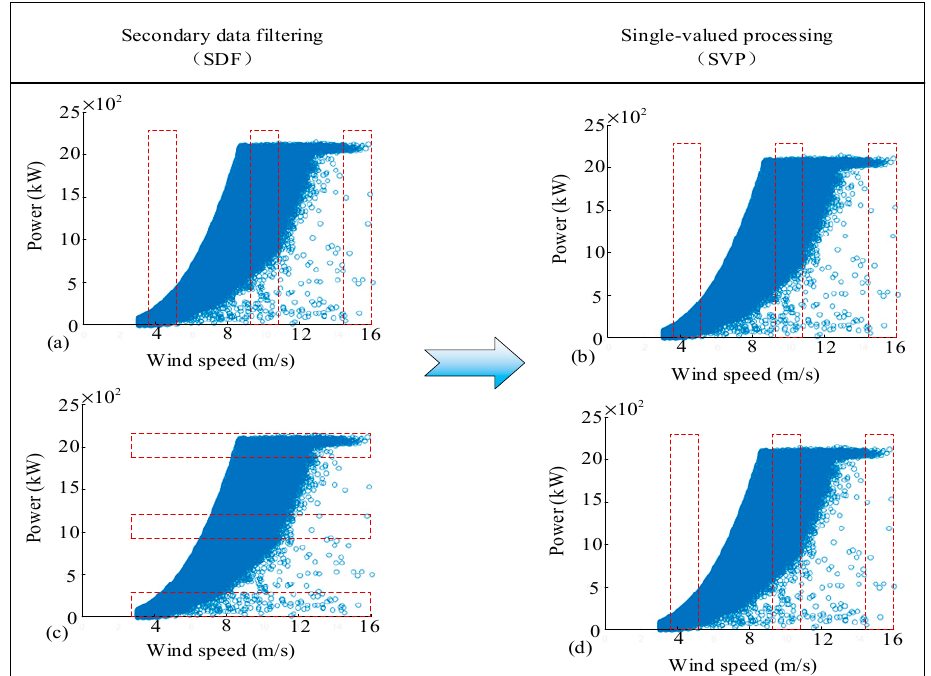
Figure 8. Different Binning benchmarks. ( a ) using binning to process wind speed in SDF; ( b ) using binning to process wind speed in SVP; ( c ) using binning to process power in SDF; ( d ) using binning to process wind speed in SVP.